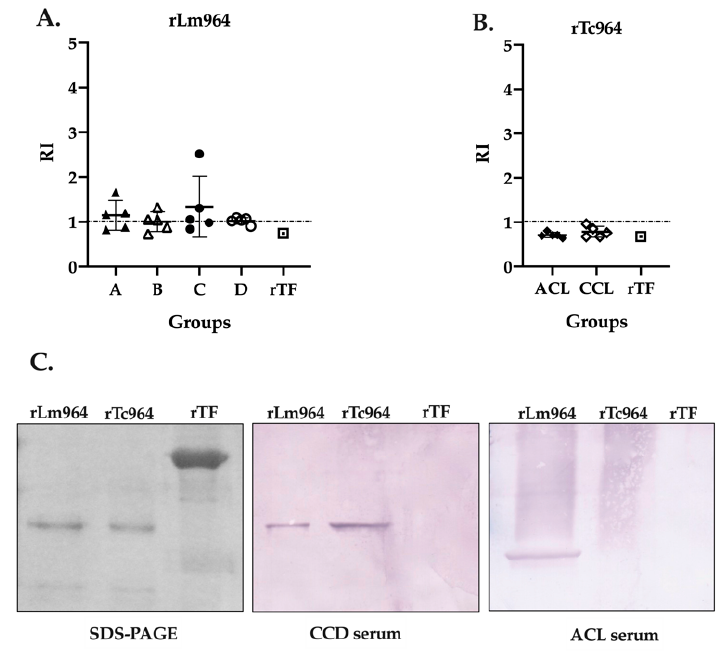
Figure 5. Cross-reactivity analysis of the Tc964 and Lm964 recombinant proteins. ( A ) ELISA test, using the rLm964 as antigen and sera of patients at different stages of CCD ( B ) ELISA test, using the rTc964 as antigen and sera of ACL and CCL patients. The recombinant protein Trigger Factor was used as negative control. Horizontal lines represent the mean ± SD of the values for each sera group. ( C ) Analysis of the antigenicity of the recombinant proteins rTc964 (37 kDa) and rLm964 (38 kDa) by Western blot. Left: 11% SDS-PAGE gel with the rTc964, rLm964 and recombinant protein Trigger Factor. Center: Western blot using the serum of a CCD patient with severity stage C (sample QX90). Right. Western blot using the serum of an ACL patient (sample 31A). In each assay, recombinant protein Trigger Factor was used as a negative control.